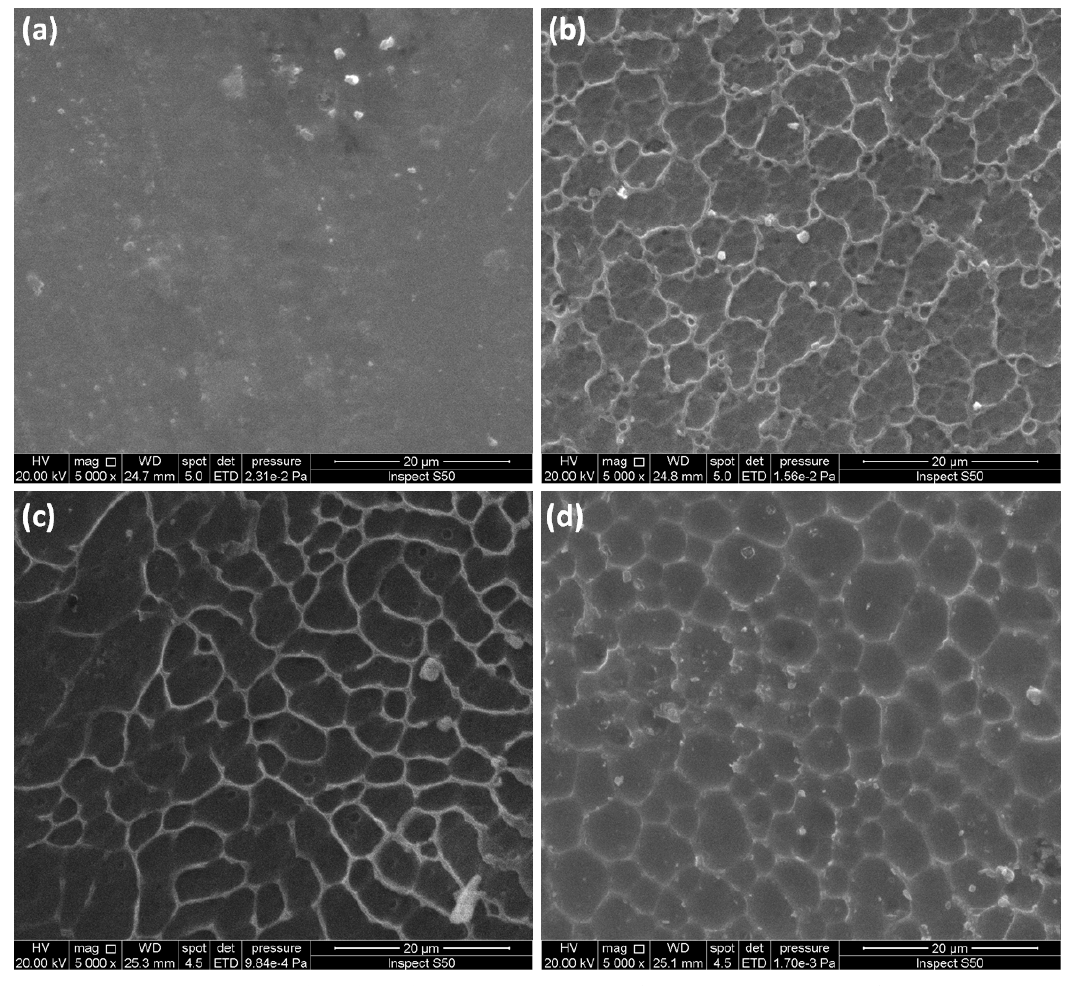
Figure 9. SEM images of PVC films after irradiation: ( a ) PVC + 1 , ( b ) PVC + 2 , ( c ) PVC + 3 , and ( d ) PVC + 4 .